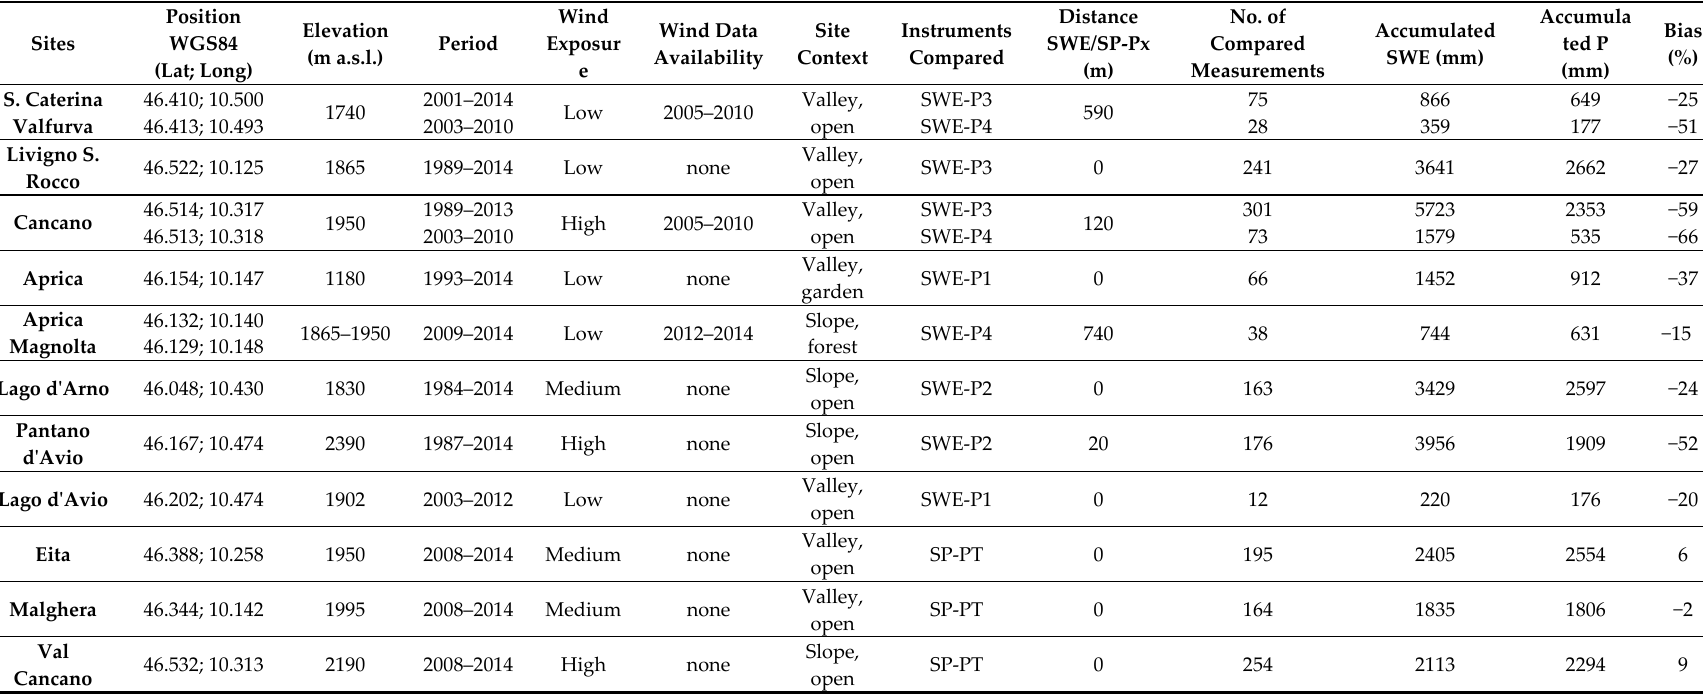
Table 1. Comparison between melted snow measured by precipitation gauges and SWE of freshly-fallen snow manually measured at snow field sites nearby. Instruments abbreviation: SWE = manual measurement of fresh fallen snow with snow board and cylindrical coring device; P1 = manual rain gauge with 1000 cm 2 top hole and melting operation made at measuring time; P2 = manual rain gauge with SIAP heating device; P3 = mechanical SIAP heated tipping-bucket recording gauge; P4 = electronic heated tipping-bucket recording gauge CAE